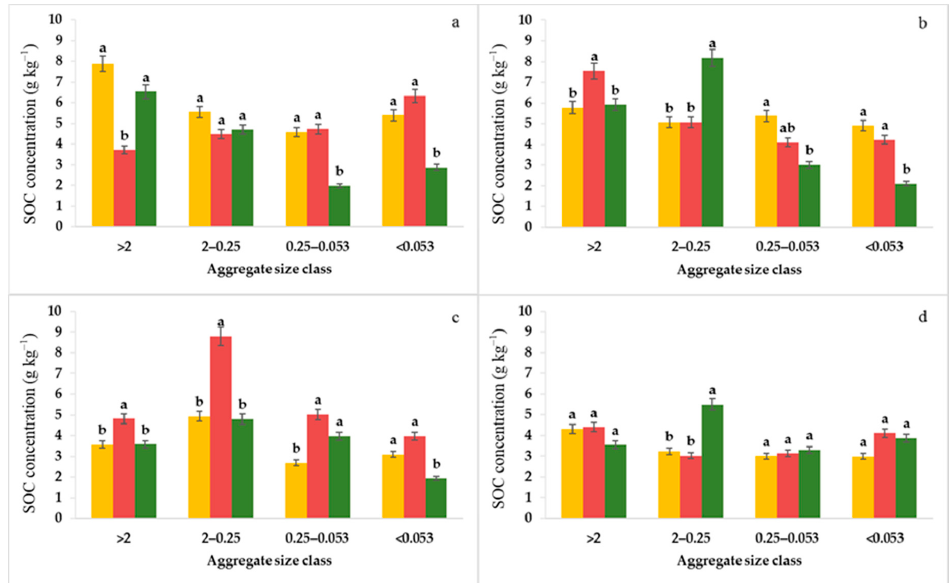
Figure 4. Soil organic carbon (SOC) concentration (g kg − 1 ) in different size of aggregates for initial situation (CT0; yellow bars), conventional-tillage (CT1; red bars) and no-till (NT+H; green bars) treatments at different horizons for ( a ) Ap horizon, ( b ) Bw horizon, ( c ) BC horizon and ( d ) C horizon. Values are given as mean ± standard error (n = 5). The different lowercase letters above the error bars for the same aggregate fraction indicate significant differences based on post-hoc tests, Tukey’s honestly significant difference (HSD) at p < 0.05 between management.